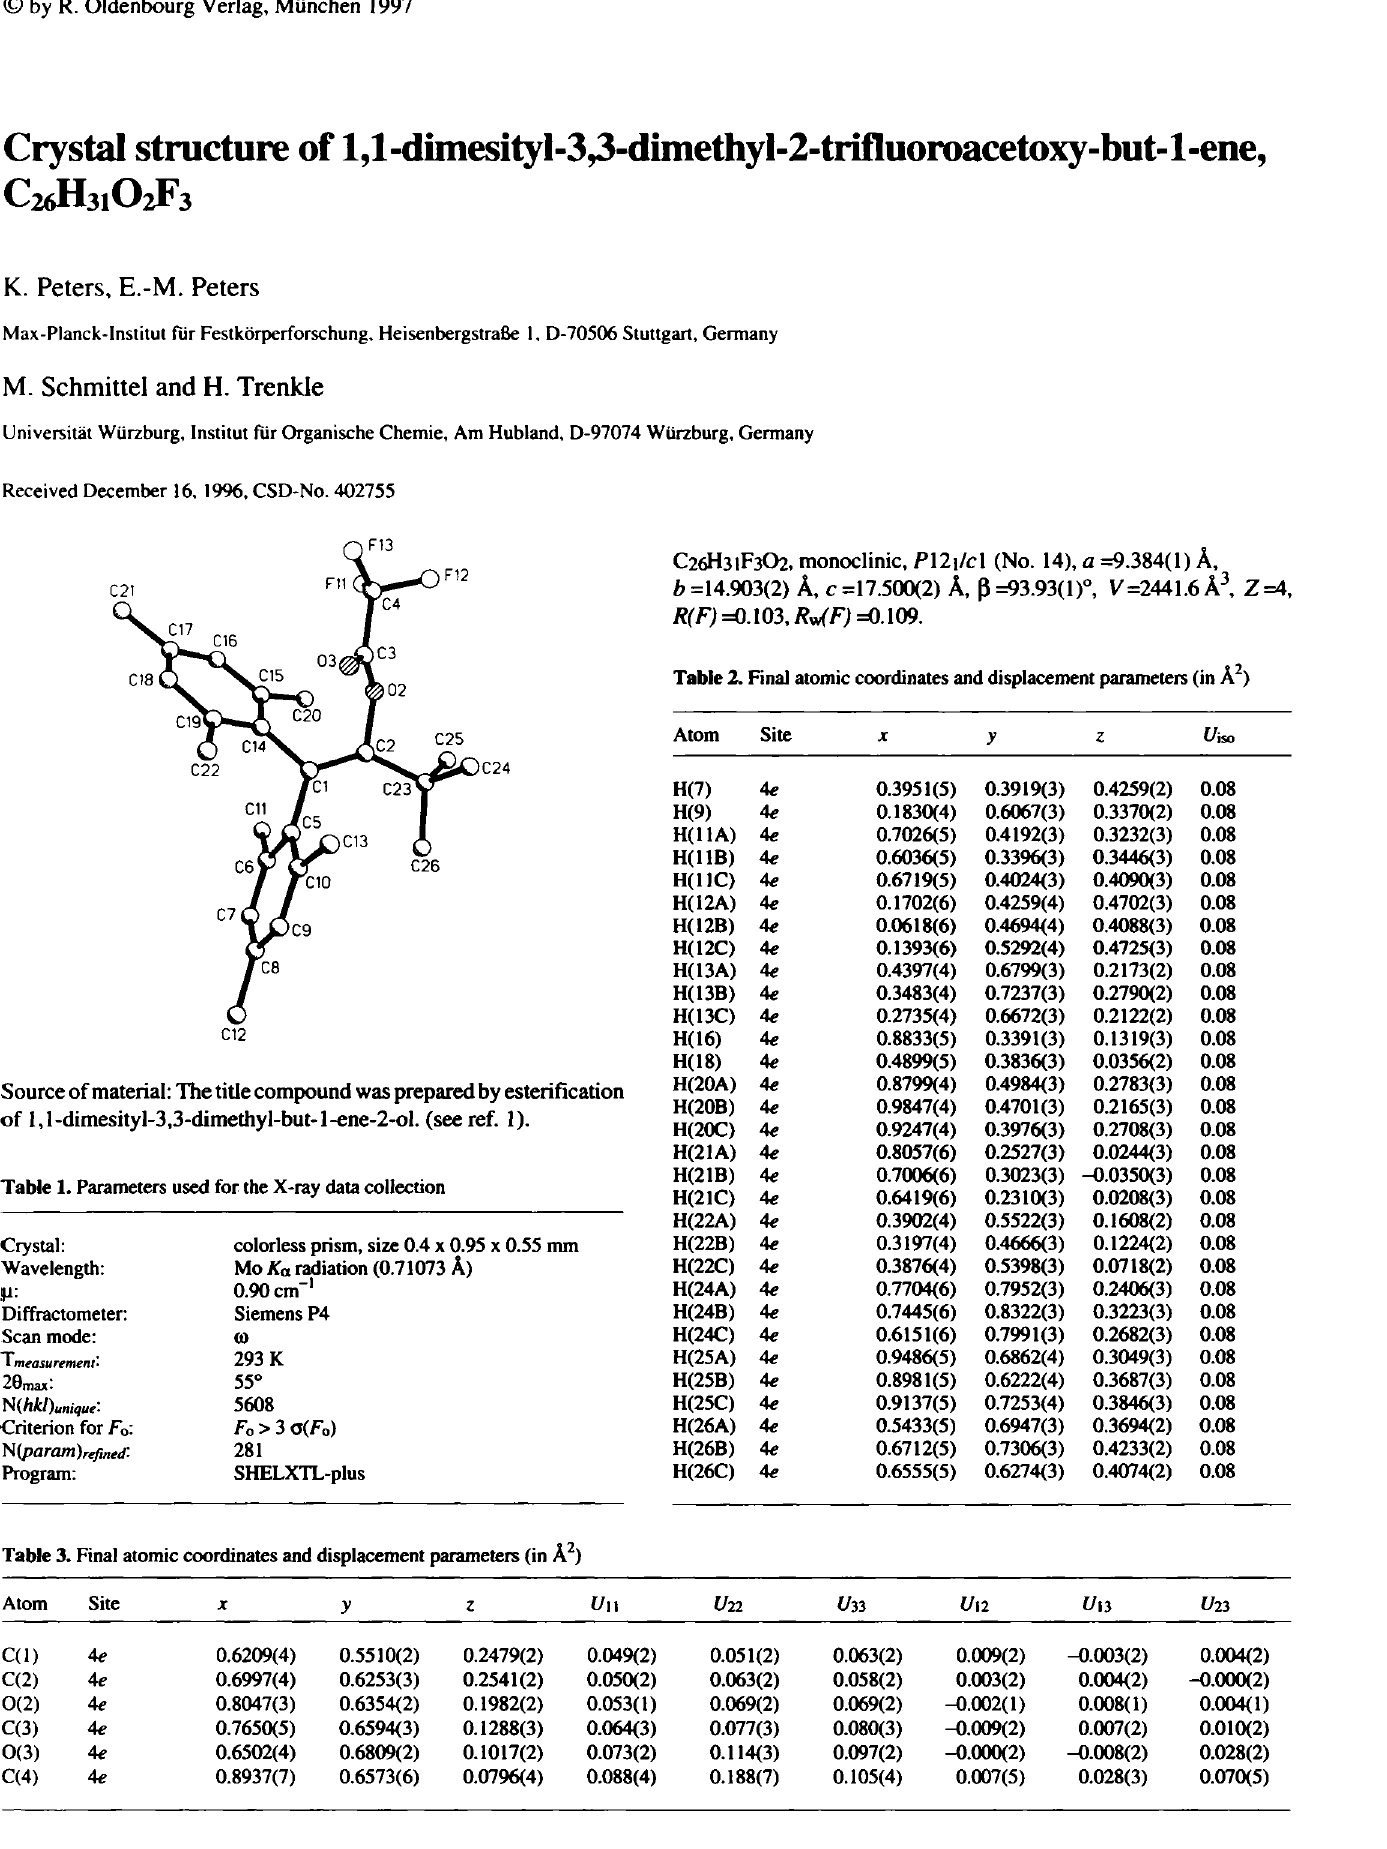
Table 1. Parameters used for the X-ray data collection Crystal: